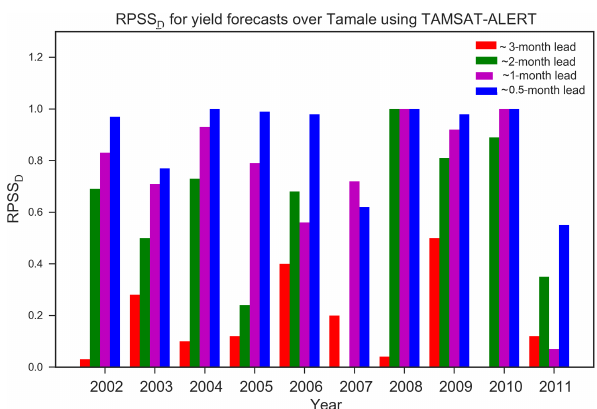
Figure 18. Discrete ranked probability skill score for the yield fore- casts over Tamale using the TAMSAT-ALERT system at different lead